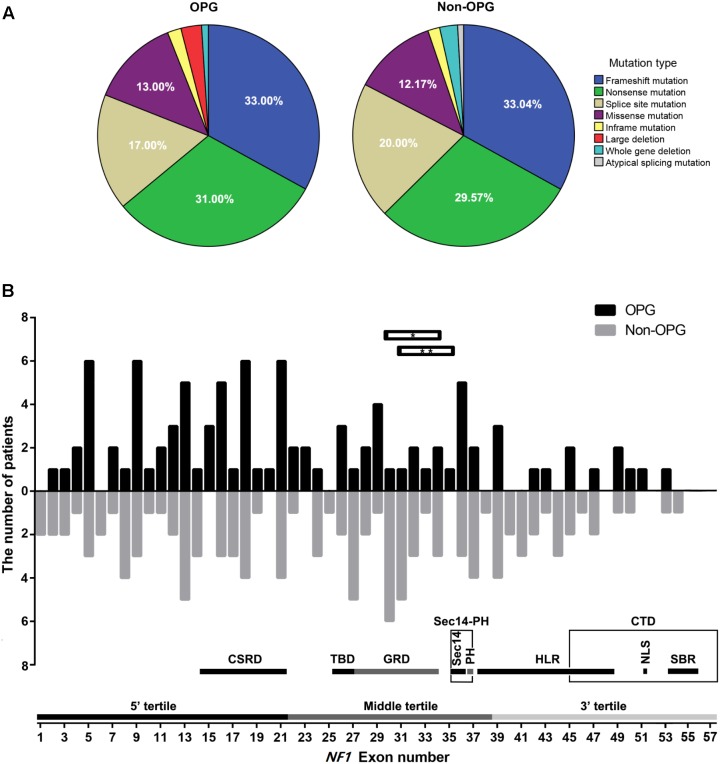
Distribution of mutation types and mutation-containing regions on the NF1 gene in patients. (A) Percentage of different mutation types in the OPG and Non-OPG groups. (B) Bar graph showing the number of patients whose mutations were located within different exons in the OPG and Non-OPG groups. Splice site mutation was included in the consensus exon. Whole-gene deletion is not shown in this figure. Horizontal bar with∗ indicates one OPG patient with a large deletion of exons 30–34. Horizontal bar with∗∗ indicates one OPG patient with a large deletion of exons 31–35. A schematic diagram showing the number of exons contained in different regions or tertiles is presented. CSRD, cysteine/serine-rich domain; TBD, tubulin-binding domain; GRD, GTPase-activating protein-related domain; Sec14, Sec14-like domain; PH, pleckstrin homology-like domain; Sec14-PH, module combining Sec14 and PH; HLR, HEAT-like repeat regions; CTD, C-terminal domain; NLS, nuclear localization signal region; SBR, syndecan-binding region.